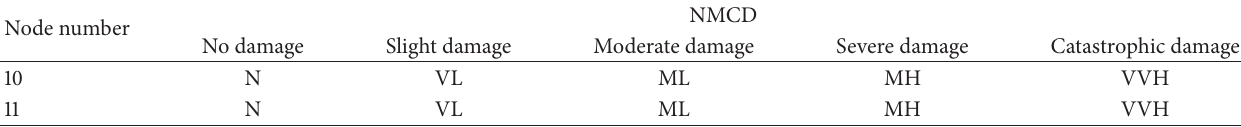
Table 5: Fuzzy rules for damage condition assessment of single location.